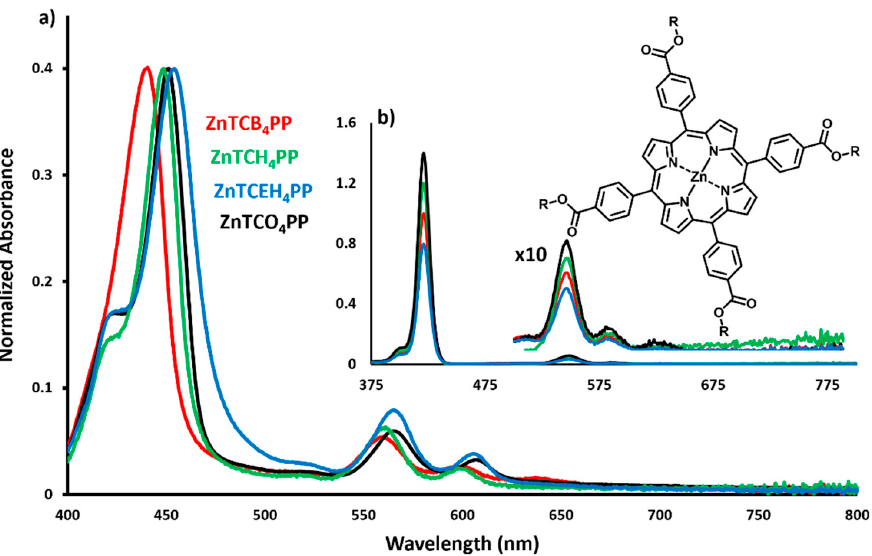
Figure 1. Normalized absorption spectra of ( a ) spin-cast thin films and; ( b ) solution of butyl derivative—ZnTCB 4 PP ( - ), hexyl derivative—ZnTCH 4 PP ( - ), 2-ethylhexyl derivative—ZnTCEH 4 PP ( - ) and octyl derivative—ZnTCO 4 PP ( - ). Inset: molecular structure of Zn-5,10,15,20-tetrakis(4-carboxyphenyl)porphyrin.